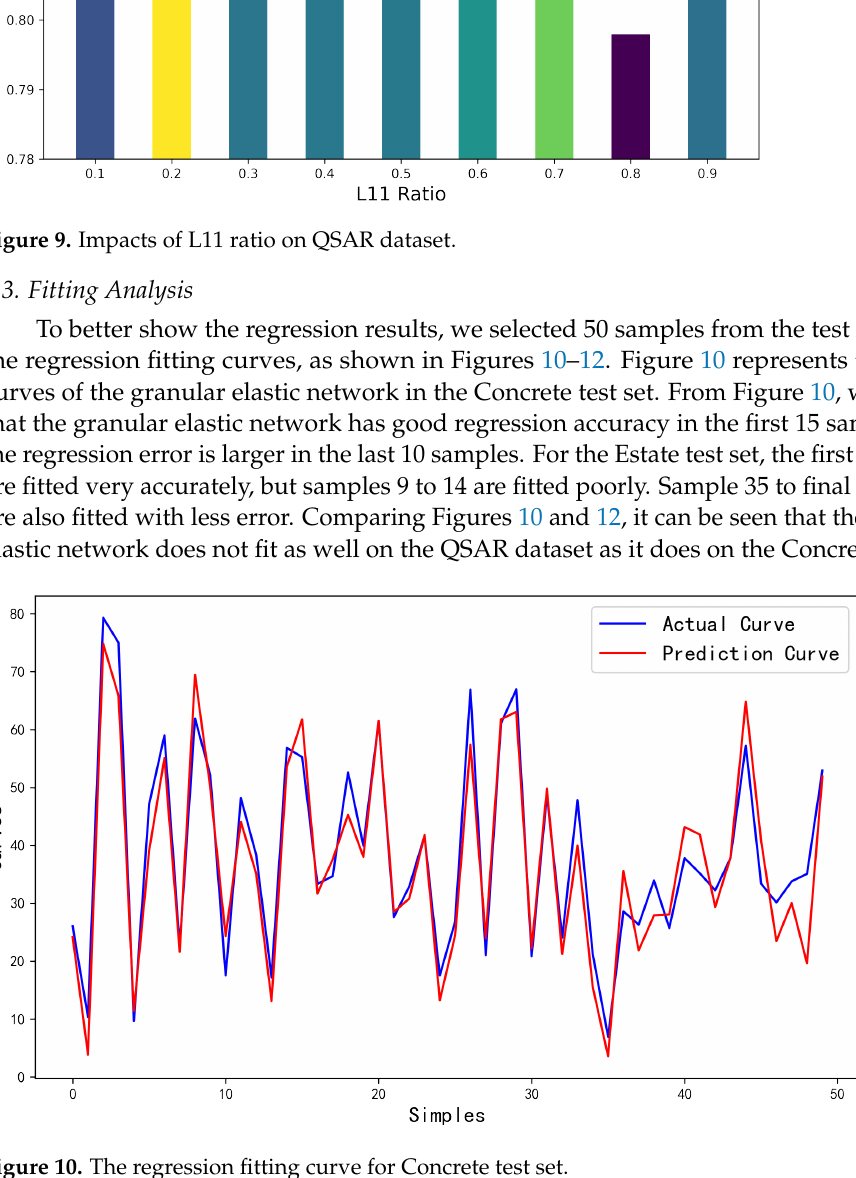
Figure 10. The regression fitting curve for Concrete test